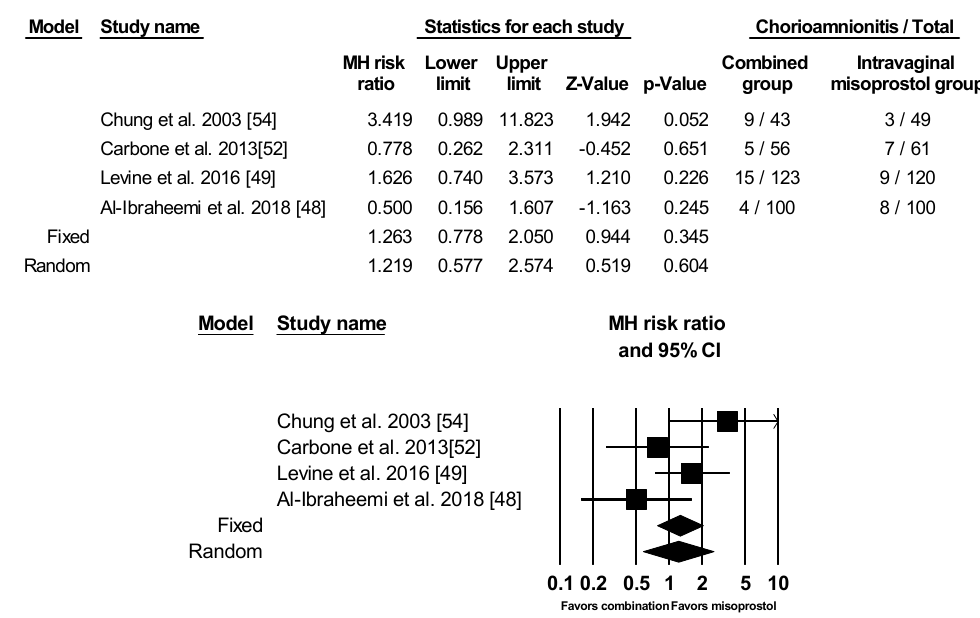
12 of 19 Figure 8. Comparison 7: Combination of intracervical Foley catheter and intravaginal misoprostol versus intravaginal misoprostol alone for cervical ripening, Outcome 7: Meconium stain. Heterogeneity: Tau 2 = 0.119; ꭓ 2 = 6.942, df = 5 ( p = 0.225); I 2 = 27.972%. Test for overall effect (fixed): Z = − 3.452 ( p = 0.001) 3.5. Other Outcomes There were no significant differences between the two groups for both risk of chorioamnionitis or neonatal intensive care unit (NICU) admission using fixed model. In regard to chorioamnionitis, four of the studies included relevant data [48,49,52,54]. One study by Lanka et al., which provided